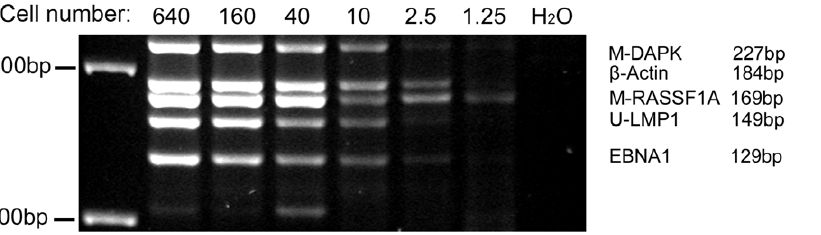
Figure 3. Evaluation of the sensitivity of the MMSP assay. A serial dilution of genomic DNA equal to specific number of Namalwa cells were bisulfite treated and used as templates for MMSP assays. Multiple markers can be co-amplified by a single reaction of MMSP from as few as 10 Namalwa cells.